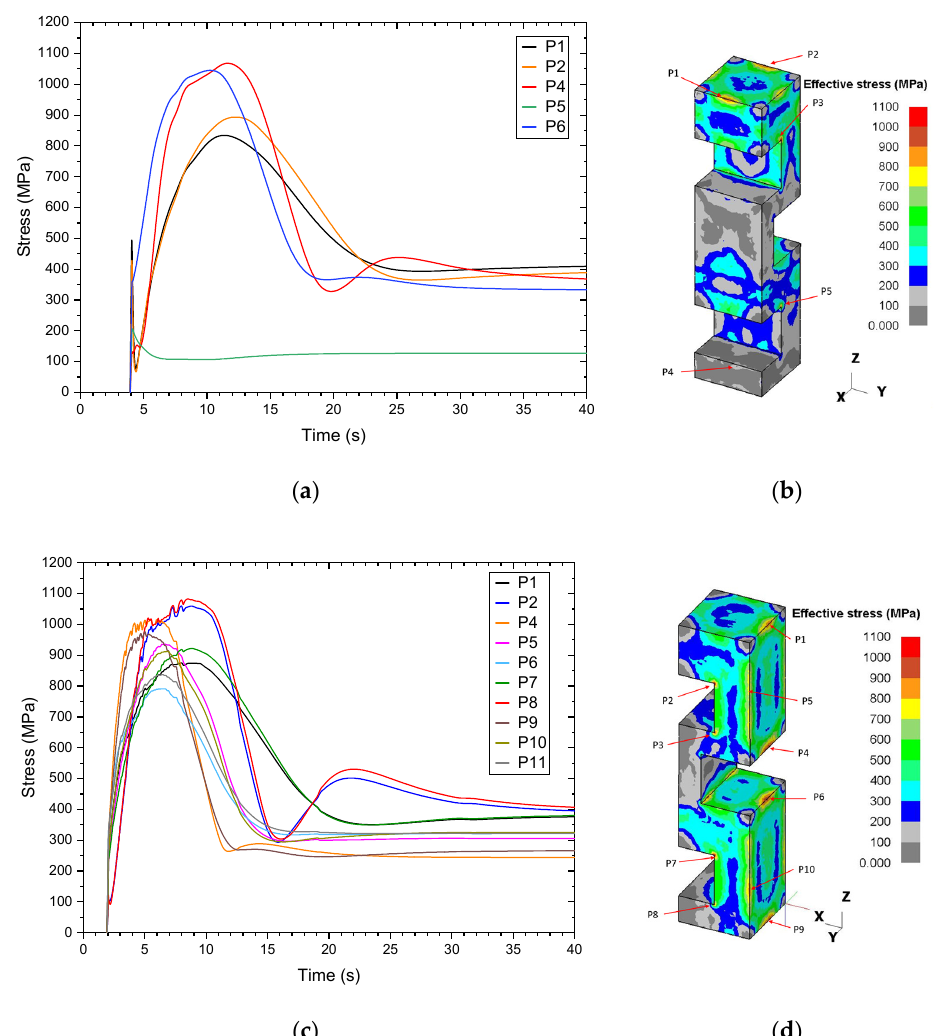
Figure 16. Stress evolution during quenching: ( a ) internal stress vs quenching time in V-WQ sample; ( b ) stress profile at 10 s after quenching starts in V-WQ sample; ( c ) internal stress vs. quenching time